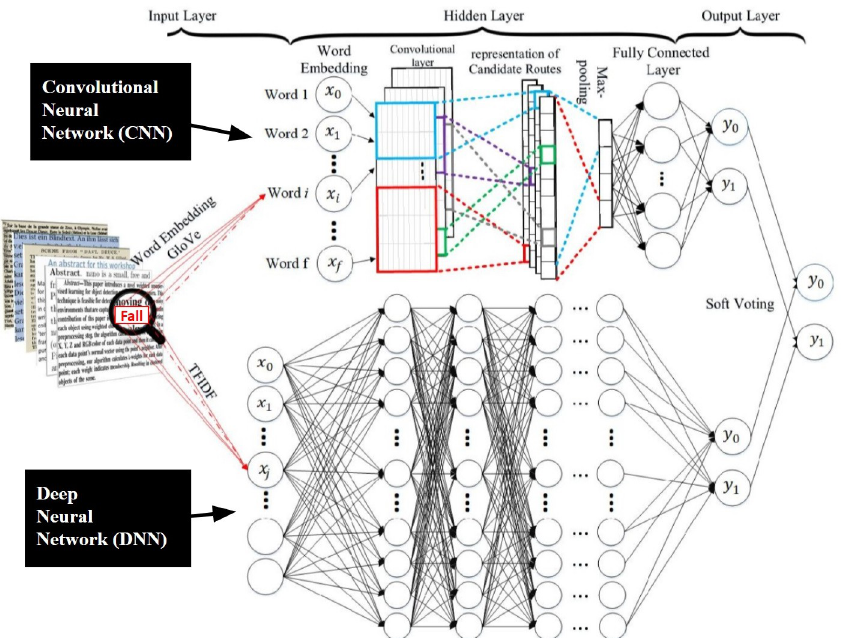
Fig 1. Overview of neural network process for NLP algorithm � . Our process incorporated both convolutional and deep neural networks into an ensemble voting process, known as random multimodel deep learning (RMDL) [8, 9]. This combination of deep learning techniques uses global vectors for word representation (GloVe) [11] input into a convolutional neural network (CNN) and term frequency-inverse document frequency (TF-IDF) input into a deep neural network (DNN), converting language into a series of vectors that convey word meaning and interact to represent combinations of words. Each of two deep learning neural network techniques (CNN at top, and DNN at bottom) then identify patterns in vector representations that correspond to notes in the training data that describe e- scooter injuries, and translate the strength of these patterns into scores from each of the two neural networks that are averaged through soft voting into a probability of e-scooter